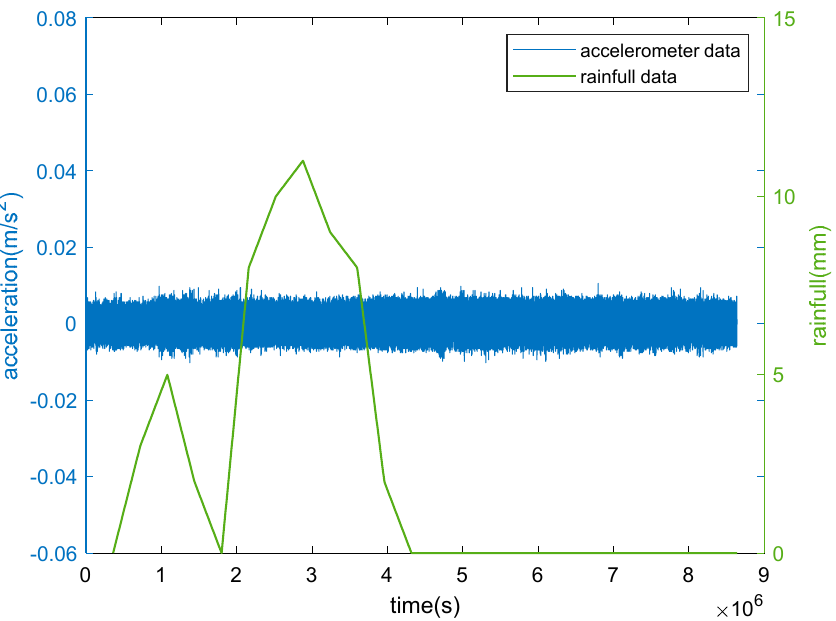
Figure 9. Comparison of the correlation between acceleration and rainfall data.